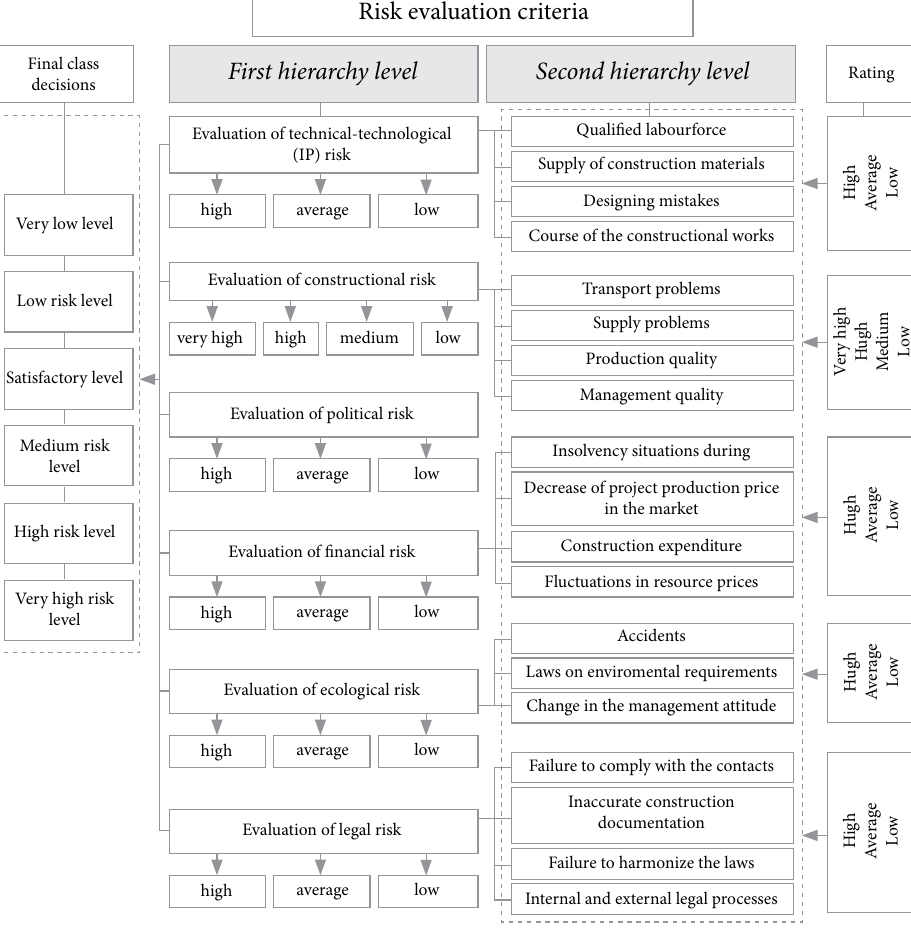
Fig. 3. The classifikator of investment risks level